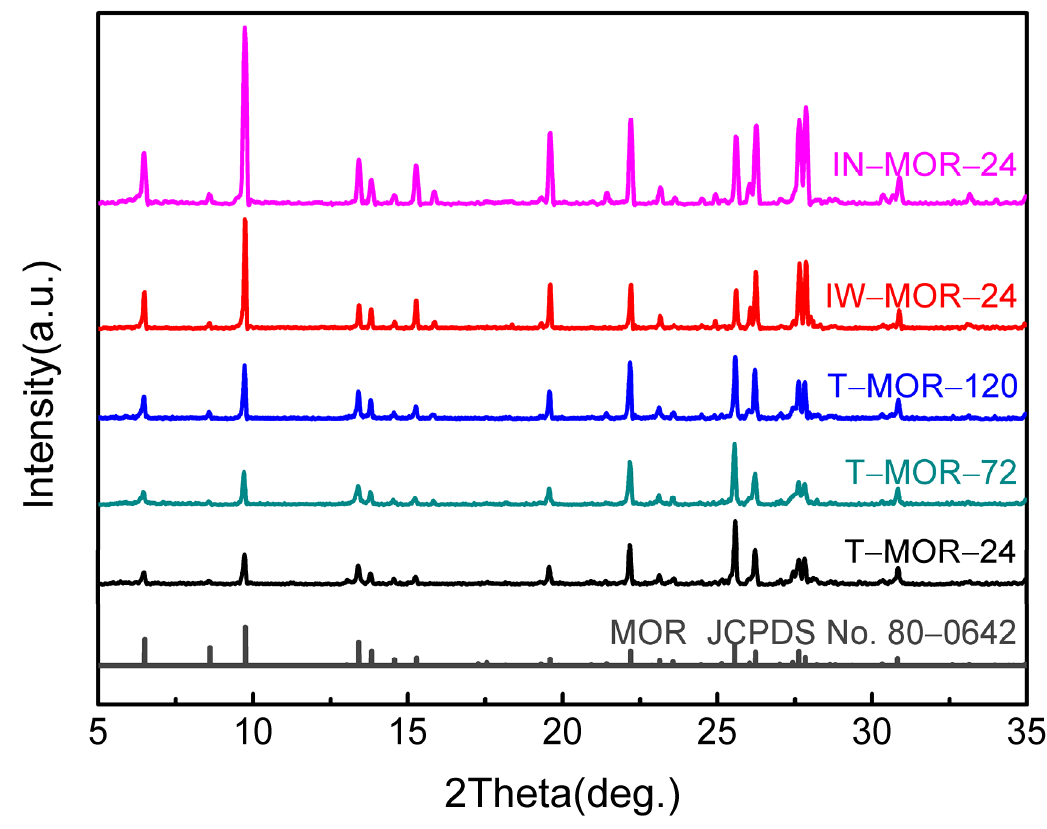
Figure 1. XRD patterns of samples prepared via traditional hydrothermal synthesis method (T–MOR– 24, T–MOR–72, T–MOR–120) and the ice-templating method (IW–MOR–24, IN–MOR–24). Table 1. The relative crystallinity of various samples.